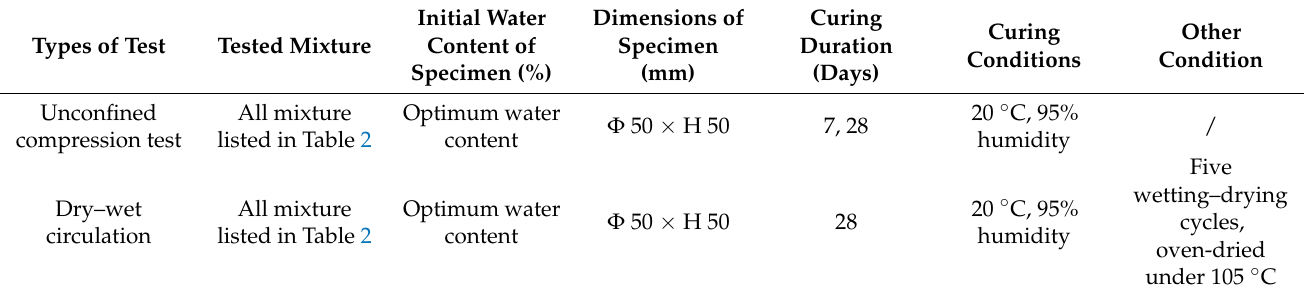
Table 3. Specifications of the testing program for